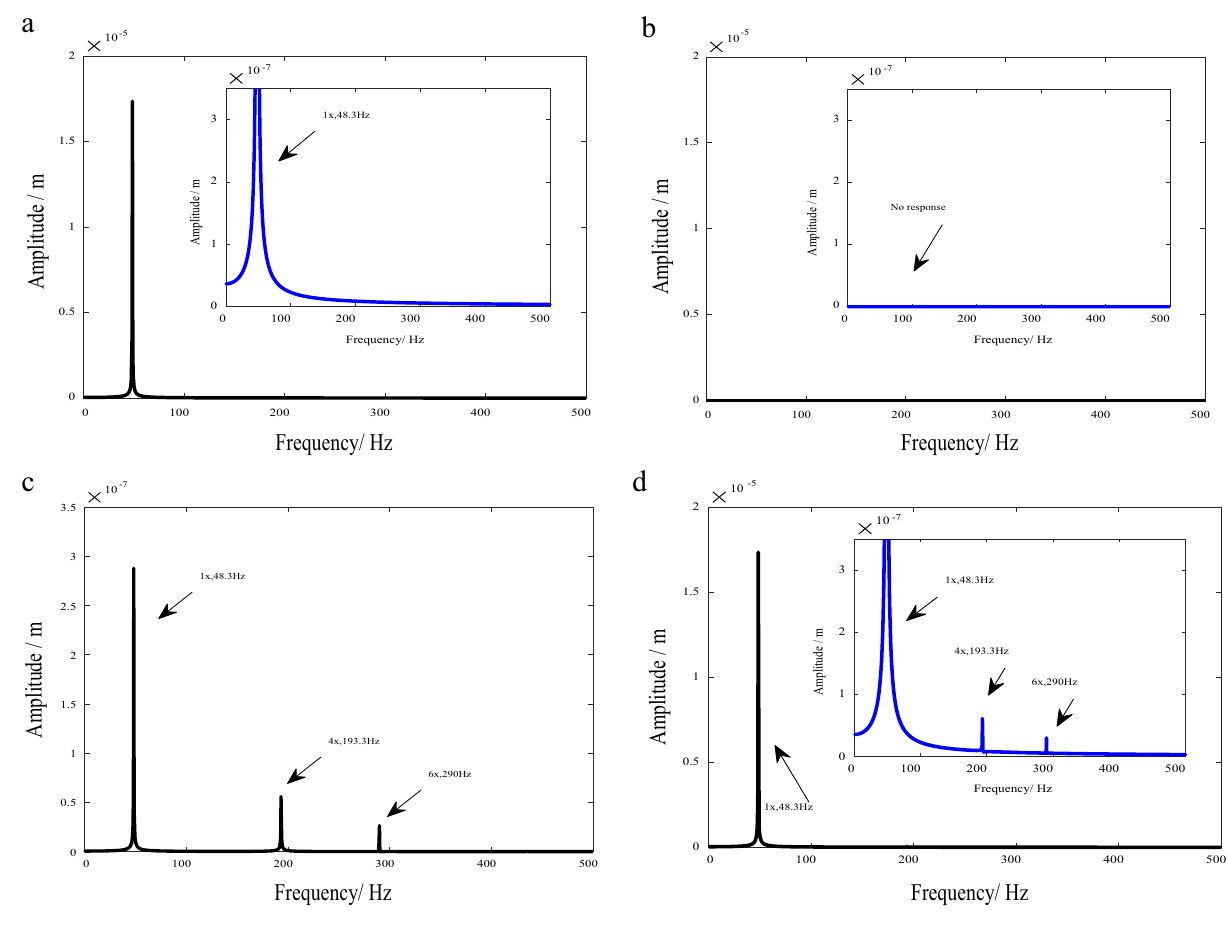
Figure 6. Spectrums of transverse vibration response ( N s = N d = 5). ( a ) Ecce. ( b ) AeroF. ( c ) Crack + AeroF. ( d ) Crack + Ecce + AeroF.